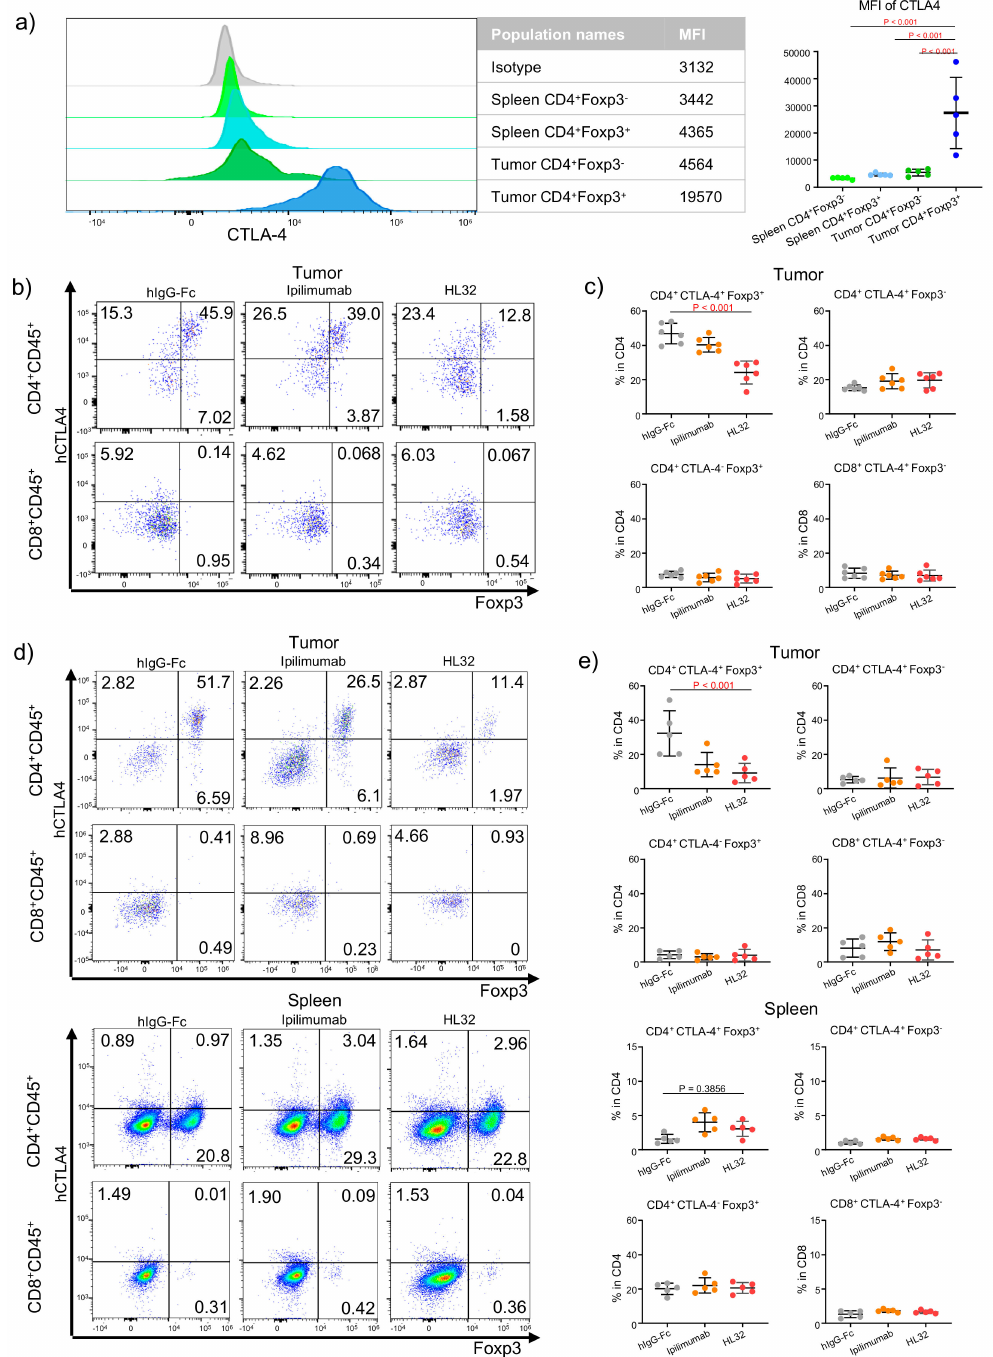
Figure 1. Improving Treg depletion in the tumor microenvironment without jeopardizing the selectivity of anti-CTLA-4 antibodies. ( a ) Comparing cell surface CTLA-4 levels among di ff erent T cell subsets. The left panel shows histograms depicting the distribution of cell surface CTLA-4 on gated T cell subsets. The right panel show summary data of mean fluorescence intensity of cell-surface CTLA-4 staining from 5 tumor-baring mice. 5 × 10 5 MC38 tumor cells were injected (s.c.) into Ctla 4 h / h